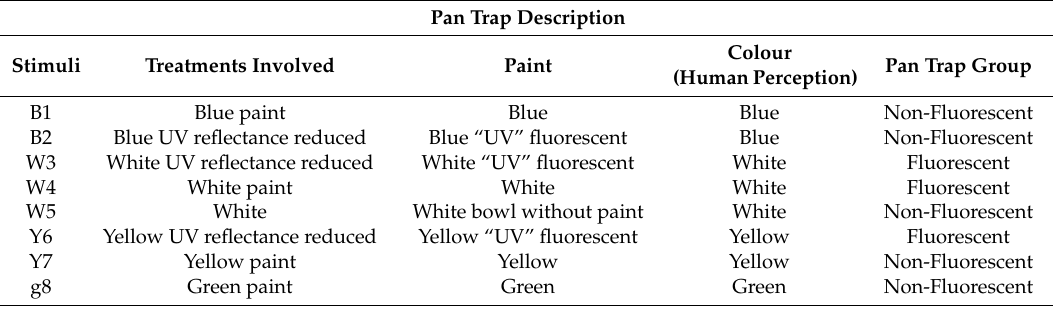
Table 1. List of the pan trap colours used in our data collection. The pan trap group (last column) in the table is categorized based on the spectral reflectance properties of each pan trap (Figure 2B). Pan Trap